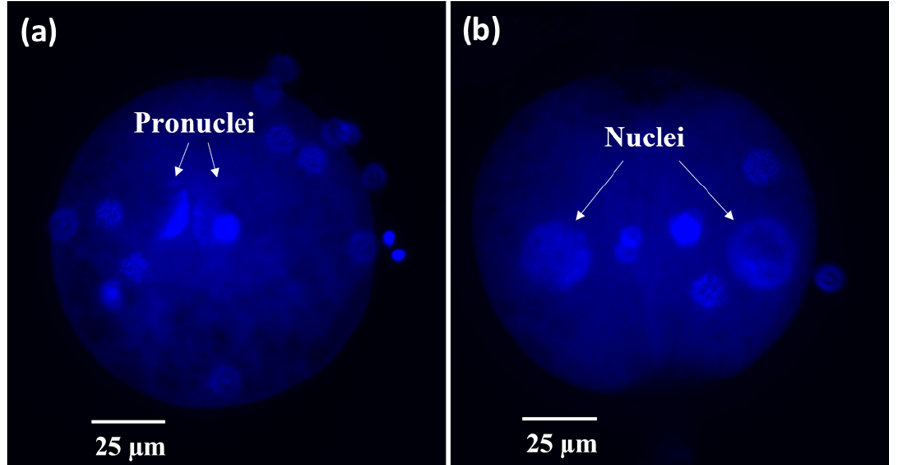
Figure 8. Representative micrographs of fertilized cat oocytes fixed at 17 h post ‐ insemination and stained with Hoechst. ( a ) Fertilized oocyte or ( b ) 2 ‐ cell embryo.